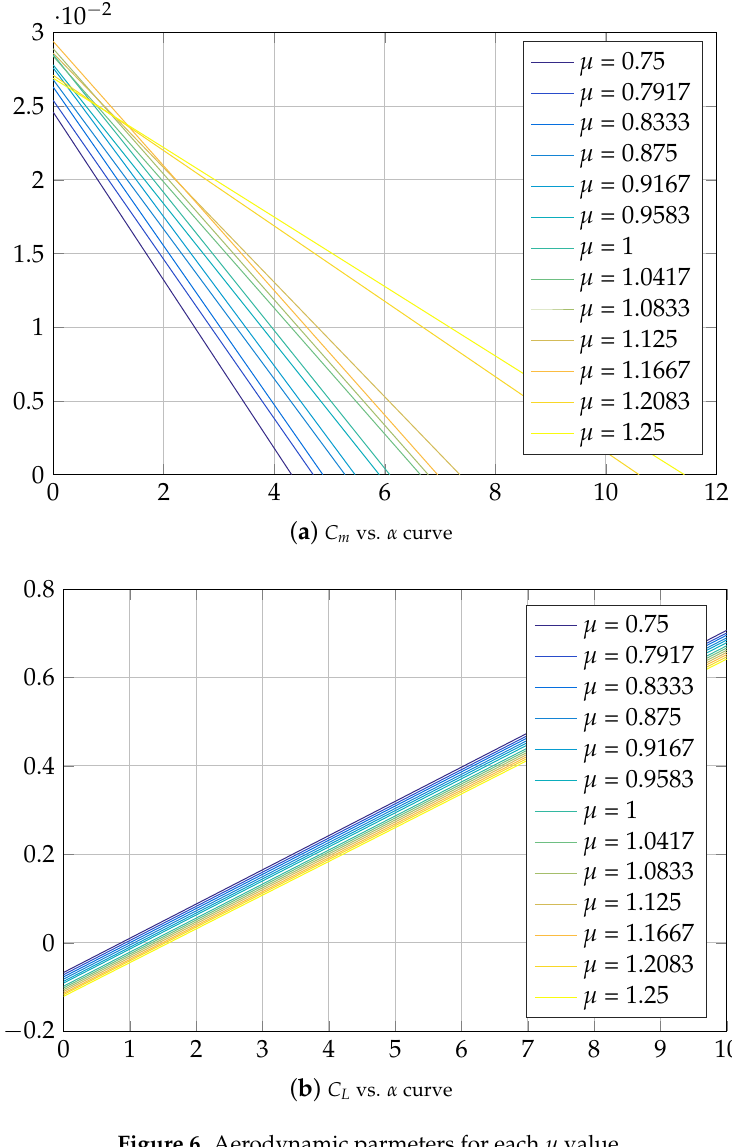
Figure 6. Aerodynamic parmeters for each µ